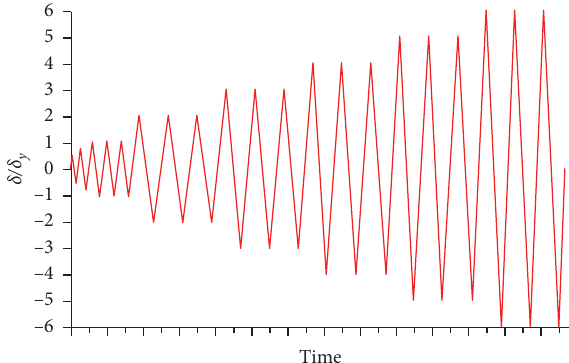
Figure 3: Horizontal loading scheme on the column top.